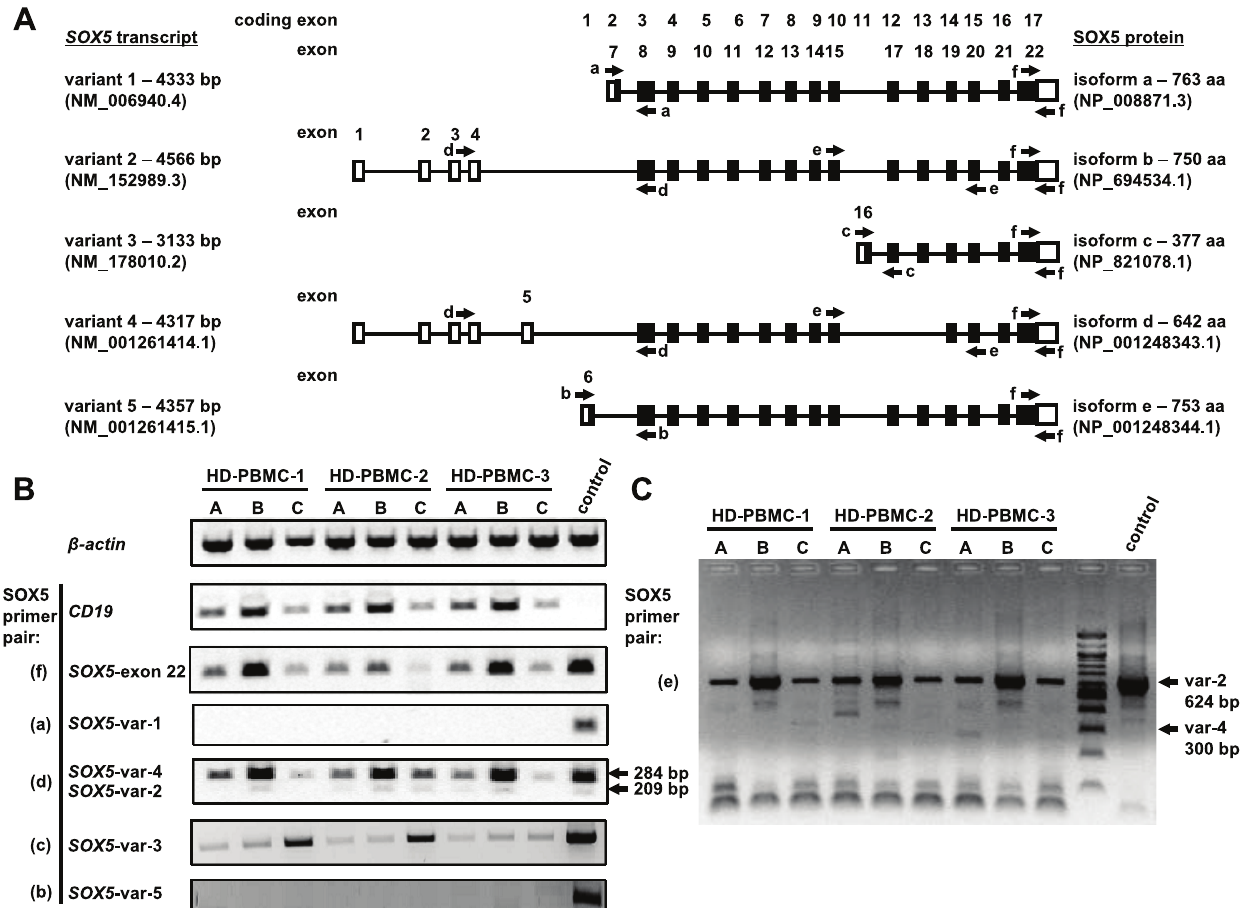
Figure 1. Expression of SOX5 transcript variants in human B cells. (A) Schematic representation of human SOX5 transcript variants. Non- coding exons are depicted as open rectangles, partial coding exons - as half open rectangles and coding exons - as filled rectangles. Primer regions are indicated with appropriate arrows. Exons and coding exons are numbered according to their location along the genomic sequence, which are drawn as black lines. (B) RT-PCR analysis for the expression of b -actin , CD19 genes and SOX5 transcript variants. HD PBMCs were separated into: A – PBMCs; B – B cells and C – non-B lymphocytes. Except for SOX5 transcript variant 3 ( SOX5 -var 3) in which human testis RNA sample served as a control, human costal cartilage cells used as a positive control in all RT-PCR reactions. In agarose gel pictures DNA markers were cut out, since they were loaded between the tested samples and the control sample. (C) RT-PCR assay performed to discriminate between SOX5 transcript variant 2 and variant 4 in samples of peripheral blood lymphocytes: A – PBMCs; B – B cells and C – non-B